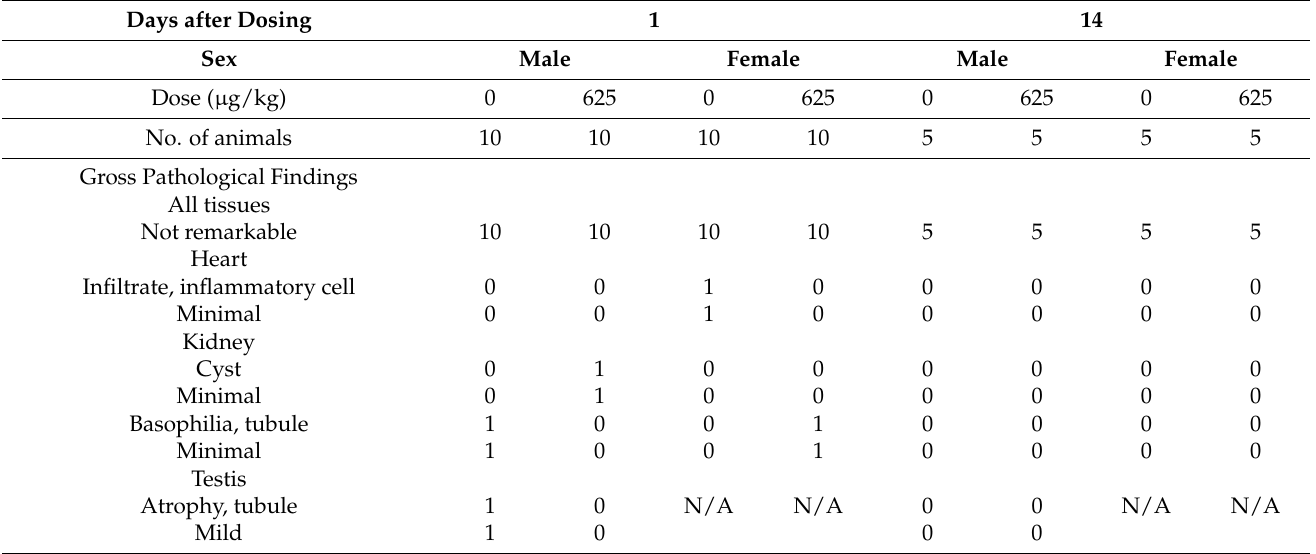
Table 5. Histopathological